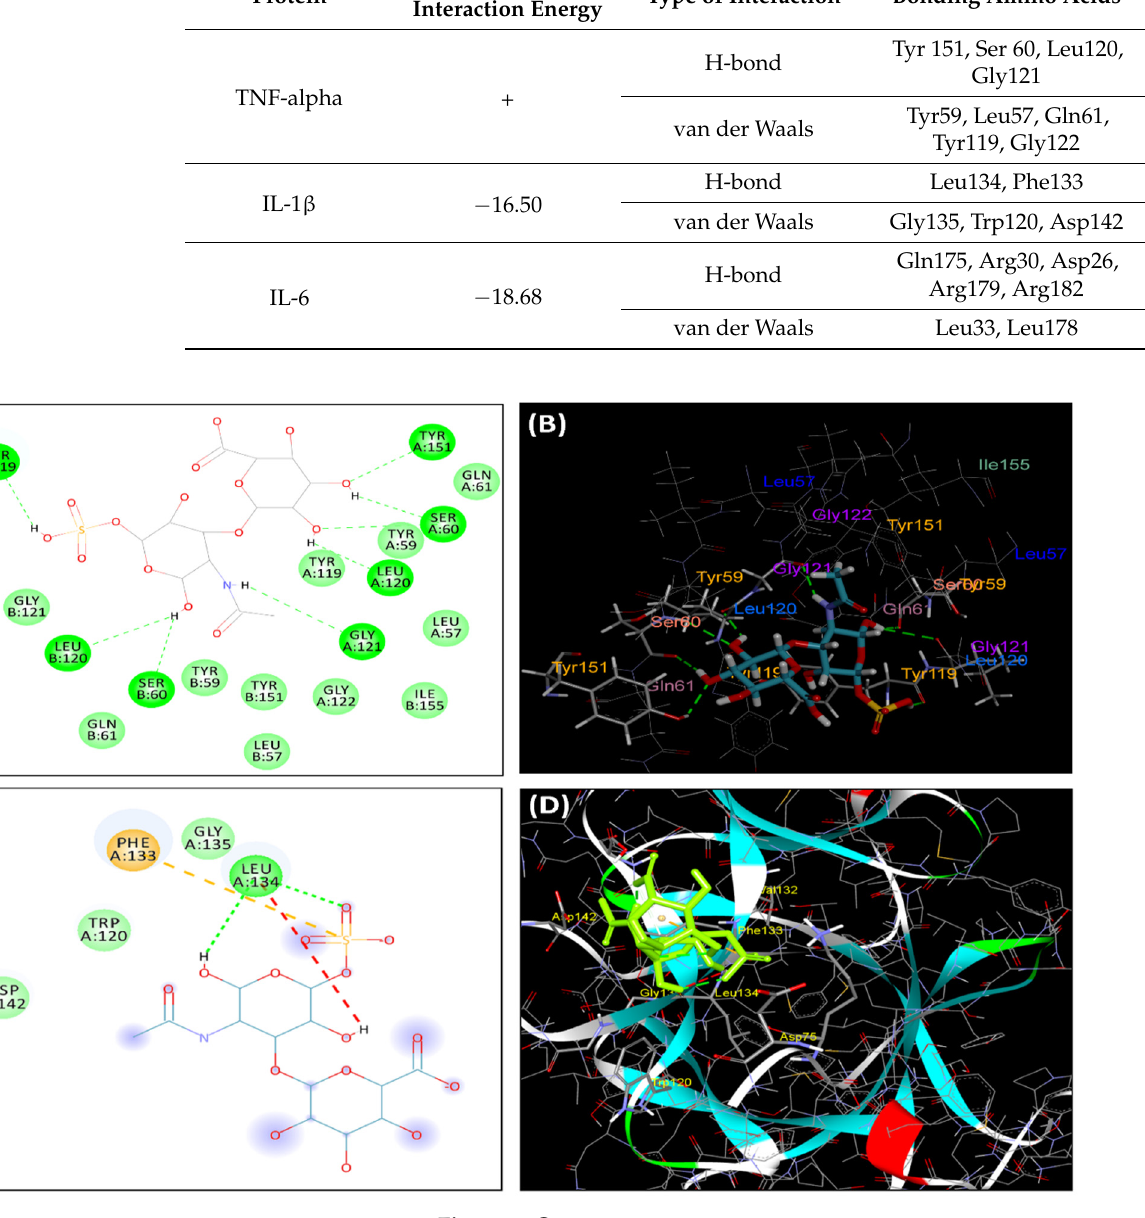
Figure 6. Interactions of chondroitin sulfate with active site of TNF-alpha pocket (2AZ5): ( A ) 2D interactions; ( B ) 3D inter- actions. Interactions of chondroitin sulfate with active site of IL-1 β (1ITB) pocket: ( C ) 2D interactions; ( D ) 3D interactions. Interactions of chondroitin sulfate with active site of IL-6 (1ALU) pocket: ( E ) 2D interactions; ( F ) 3D interactions. The hydrogen bonds are indicated with green dashed lines, and the van der Waals forces are in white. 4. Discussion In the present investigation, administration of chondroitin sulfate concluded a sig- nificant ( p < 0.05) and dose-dependent attenuation of PTZ- and pilocarpine-induced sei- zures in mice. Therefore, our data provided the evidence of pharmacological modulation of inflammatory mediators and antioxidant elements under chronic seizures, which have been suggested to provide neuroprotective effects during epileptic seizures by attenuat- ing the kindling severity score induced by PTZ. Pilocarpine-induced spontaneous recur- rent seizures were reduced in Swiss albino mice rodents. Nevertheless, further bimolecu- lar studies are required to elucidate the involvement of chondroitin sulfate in epileptic mice.